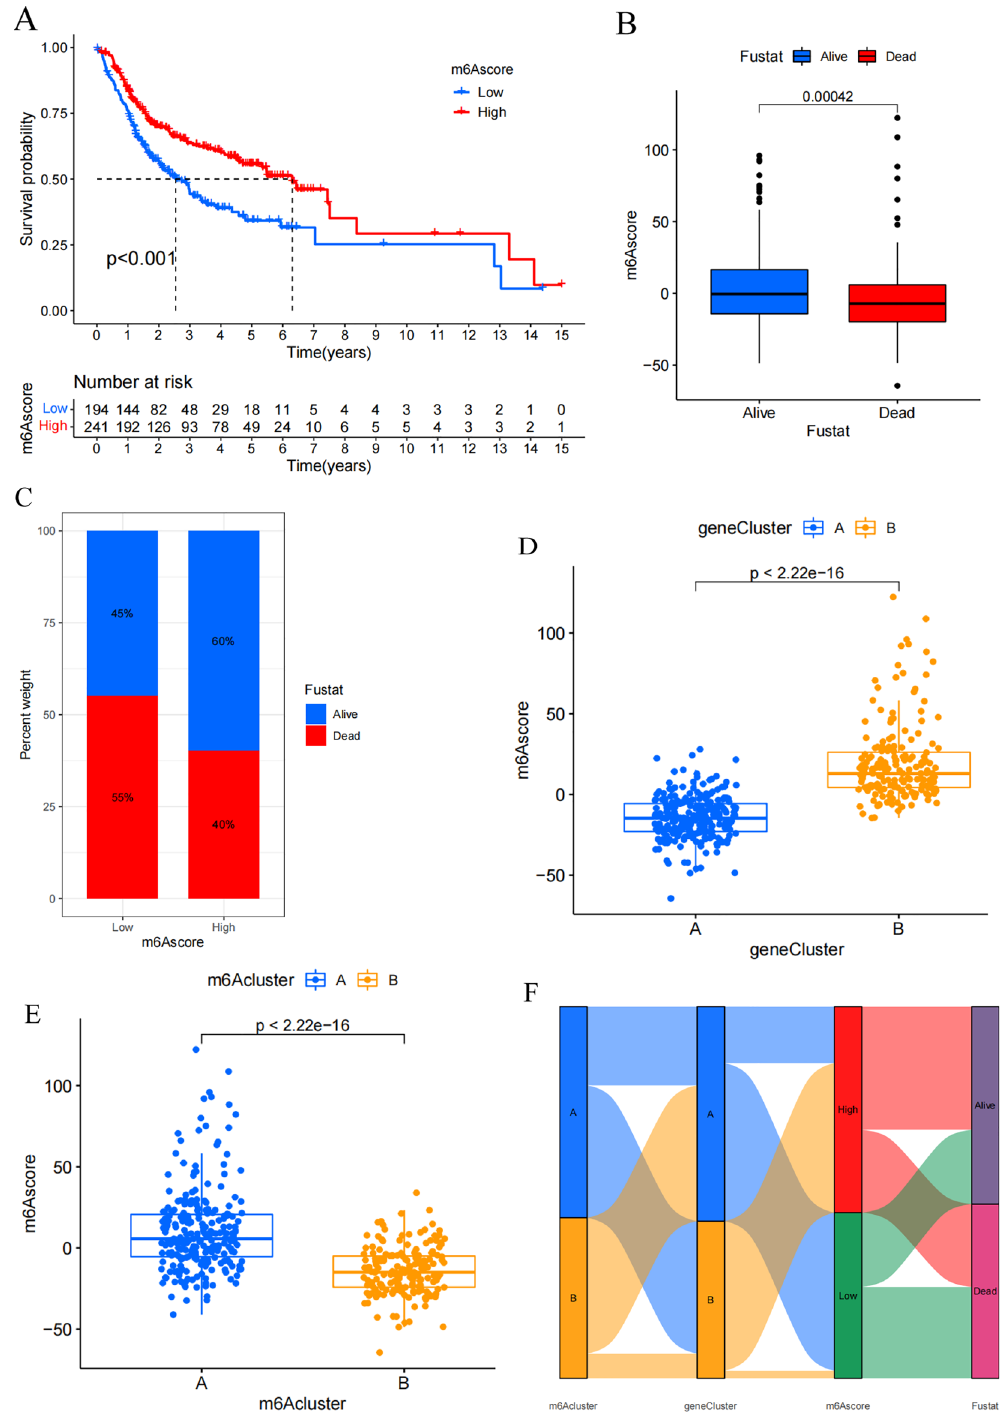
Figure 5. High m 6 A score associated with better prognosis. ( A ) Kaplan–Meier survival analysis of OSCC patients in different m 6 A score groups. Low-m 6 A score group, blue curve; High-m 6 A score group, red curve. Log-rank p < 0.001 showed a significant survival difference between two groups. ( B ) Differences in m 6 A score between alive and dead patients in TCGA and GSE41613 cohort. Alive, blue; Dead, red. Top edge of box: upper quartile; bottom edge of box: lower quartile; internal horizontal line: median. Dots above and below: outliers. The upper number represented p value. ( C ) The proportion of alive and dead patients in the low-m 6 A score group and the high-m 6 A score group. Alive, blue; Dead, red. Numbers in the barplots represented percentages. ( D ) Differences in m 6 A score between m 6 A clusters. Cluster A, blue; Cluster B, yellow. Top edge of box: upper quartile; bottom edge of box: lower quartile; internal horizontal line: median. Dots represented samples and the upper number represented p value. ( E ) Differences in m 6 A score between gene clusters. Gene cluster A, blue; Gene cluster B, yellow. Top edge of box: upper quartile; bottom edge of box: lower quartile; internal horizontal line: median. Dots represented samples and the upper number represented p value. ( F ) Sankey diagram showing the correlations among m 6 A clusters, gene clusters, m 6 A score and